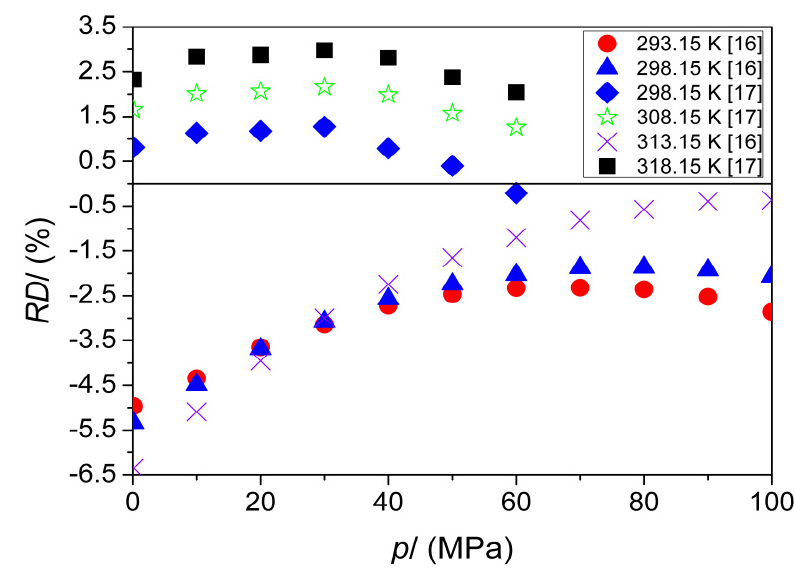
Figure 10. Comparison of the internal pressure of 1-butanol as a function of pressure obtained in this work ( p int , this work ) with the literature values ( p int , lit ) [16,17] presented as relative deviations RD s ( RD / % = 100 · ( p int , this work − p int , lit ) / p int , this work ).